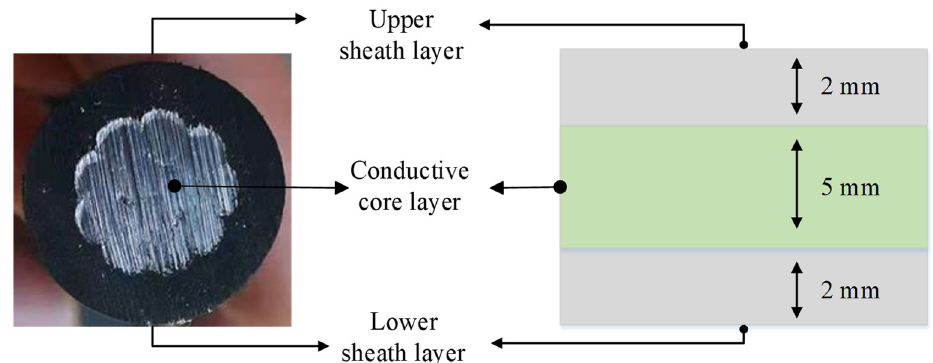
Figure 1. Cable structure.